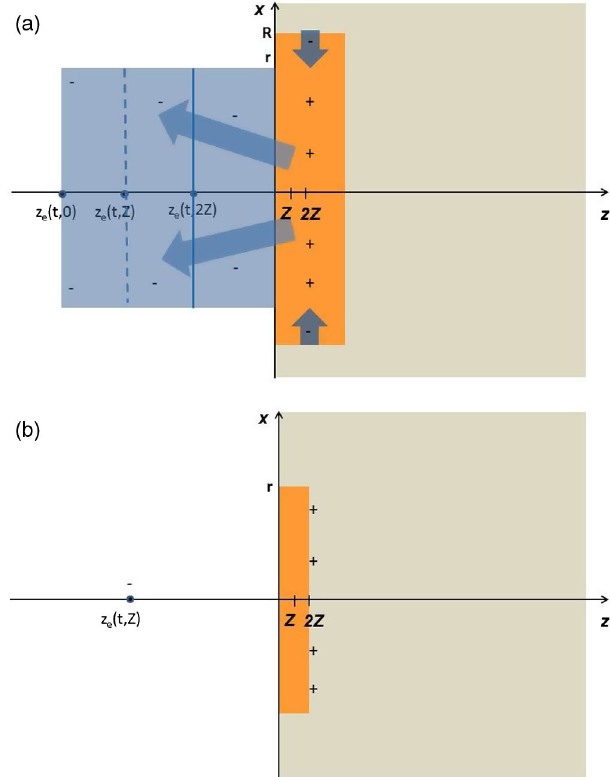
FIG. 5. (a) schematic picture of the expected charge distribution shortly after the expulsion (long arrows) of surface electrons; short arrows represent the inward motion of the lateral electrons; (b) simplified charge distribution generating the effective poten- tial